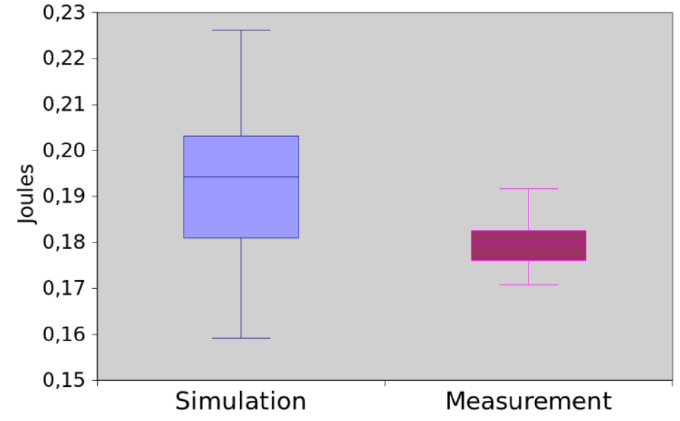
Figure 15. Power consumption of the